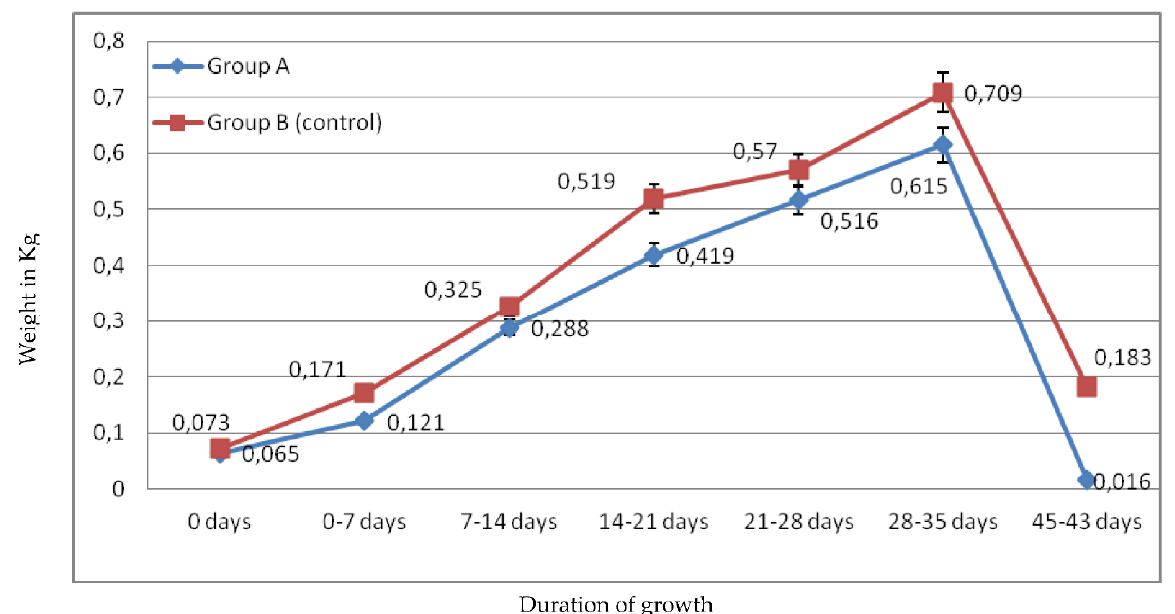
Figure 2. Broiler average feed consumption/week. Broilers of group A, fed with ration supplemented with pulp and seeds of pomegranate and avocado by-products, and broilers of group B (control group), fed with basal ration.